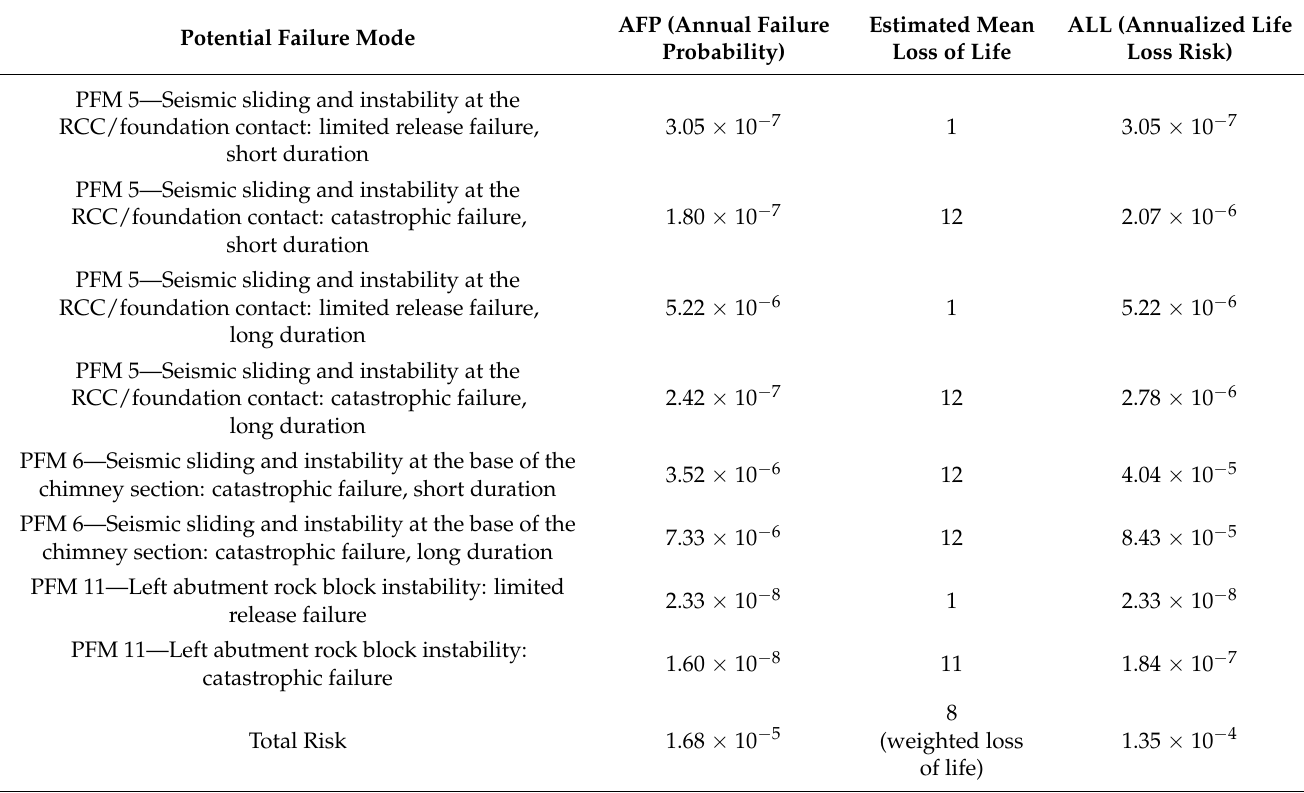
Table 12. Summary of risk analysis results for the new Scoggins RCC